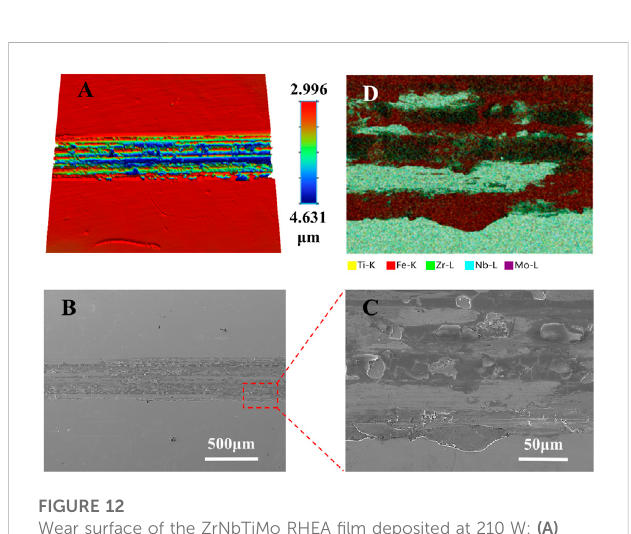
FIGURE 12 Wear surface of the ZrNbTiMo RHEA fi lm deposited at 210 W: (A) 3D image; (B) and (C) SEM image; (D) Face-scan element distribution map of (C)